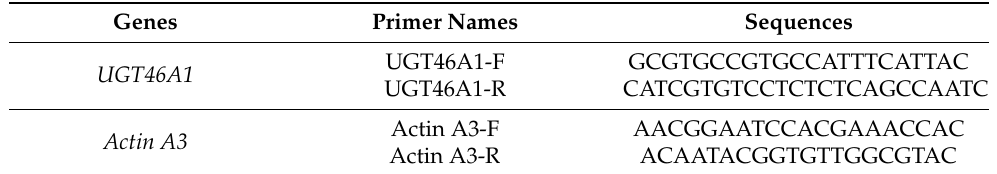
Table 1. Primers information for qRT-PCR.